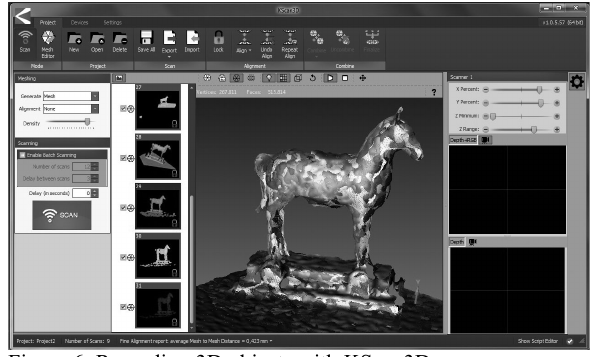
Figure 6: Recording 3D objects with KScan3D